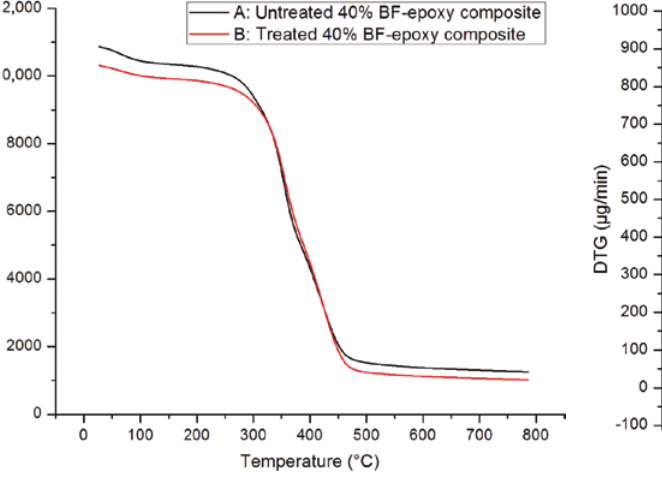
Figure 7: DTG thermogram of untreated and treated 10% BF-epoxy composites.